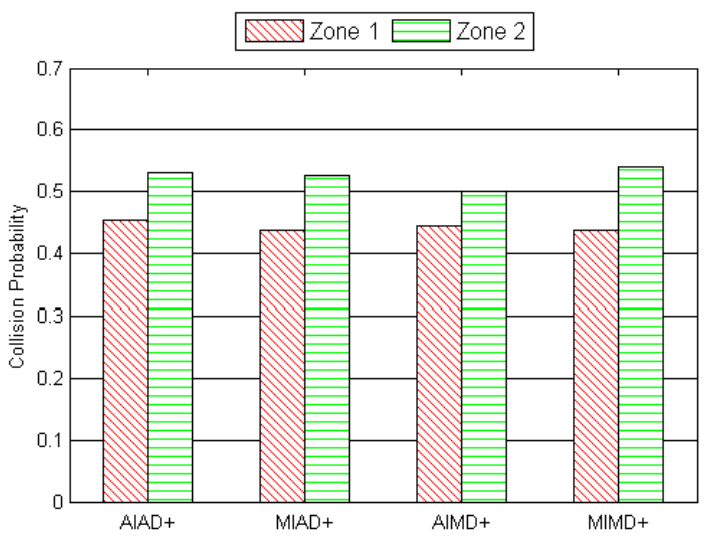
Figure 10. Collision probability comparison between four transmission control